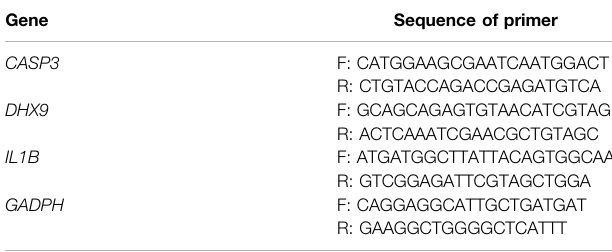
TABLE 1 | Sequences of the primers used in